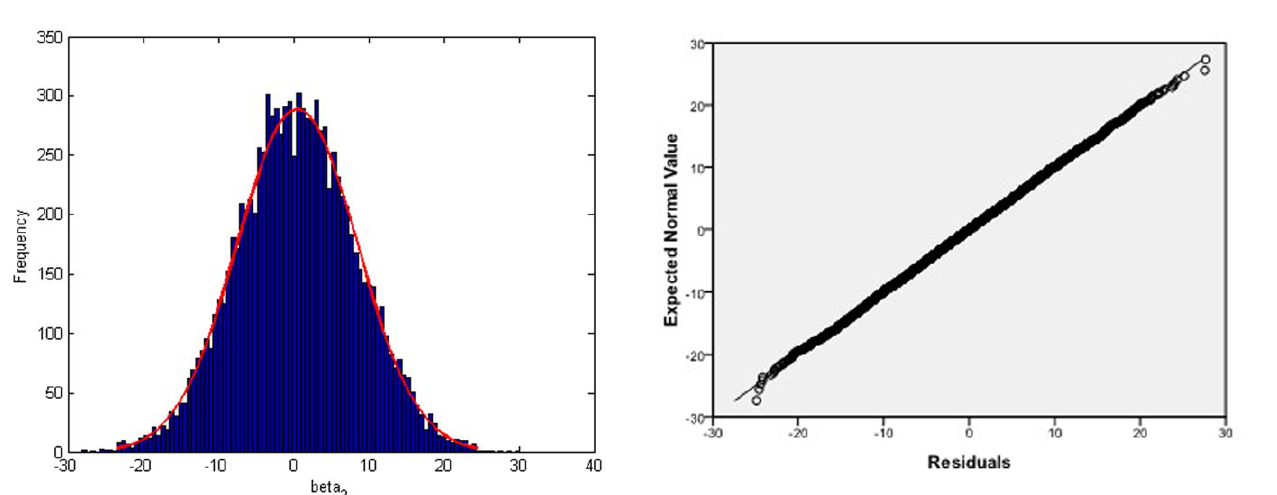
Figure 12. Histogram and asymptotic distribution for ^ bb 2 of OLS when the variance function of the error term is